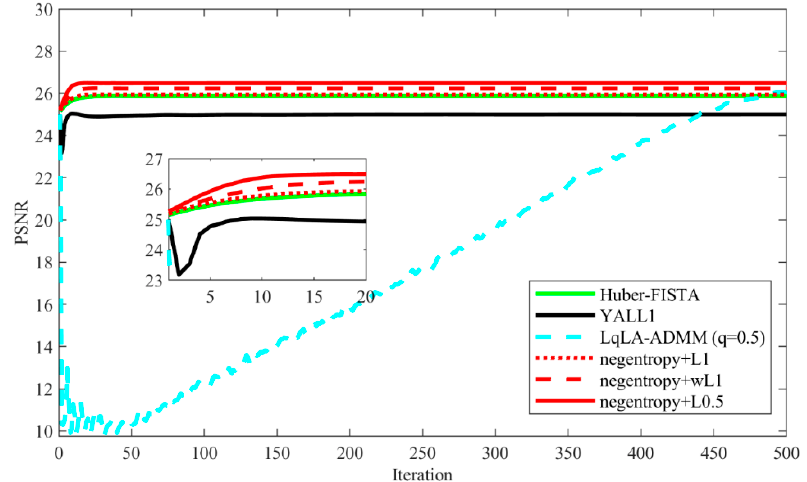
Figure 14. PSNR versus iterations in recovering the brain MRI image.